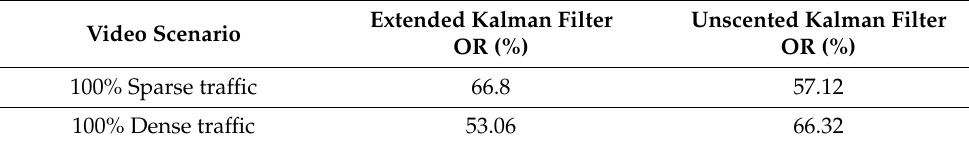
Table 1. Accuracy of different fusion architecture with fixed tracker.